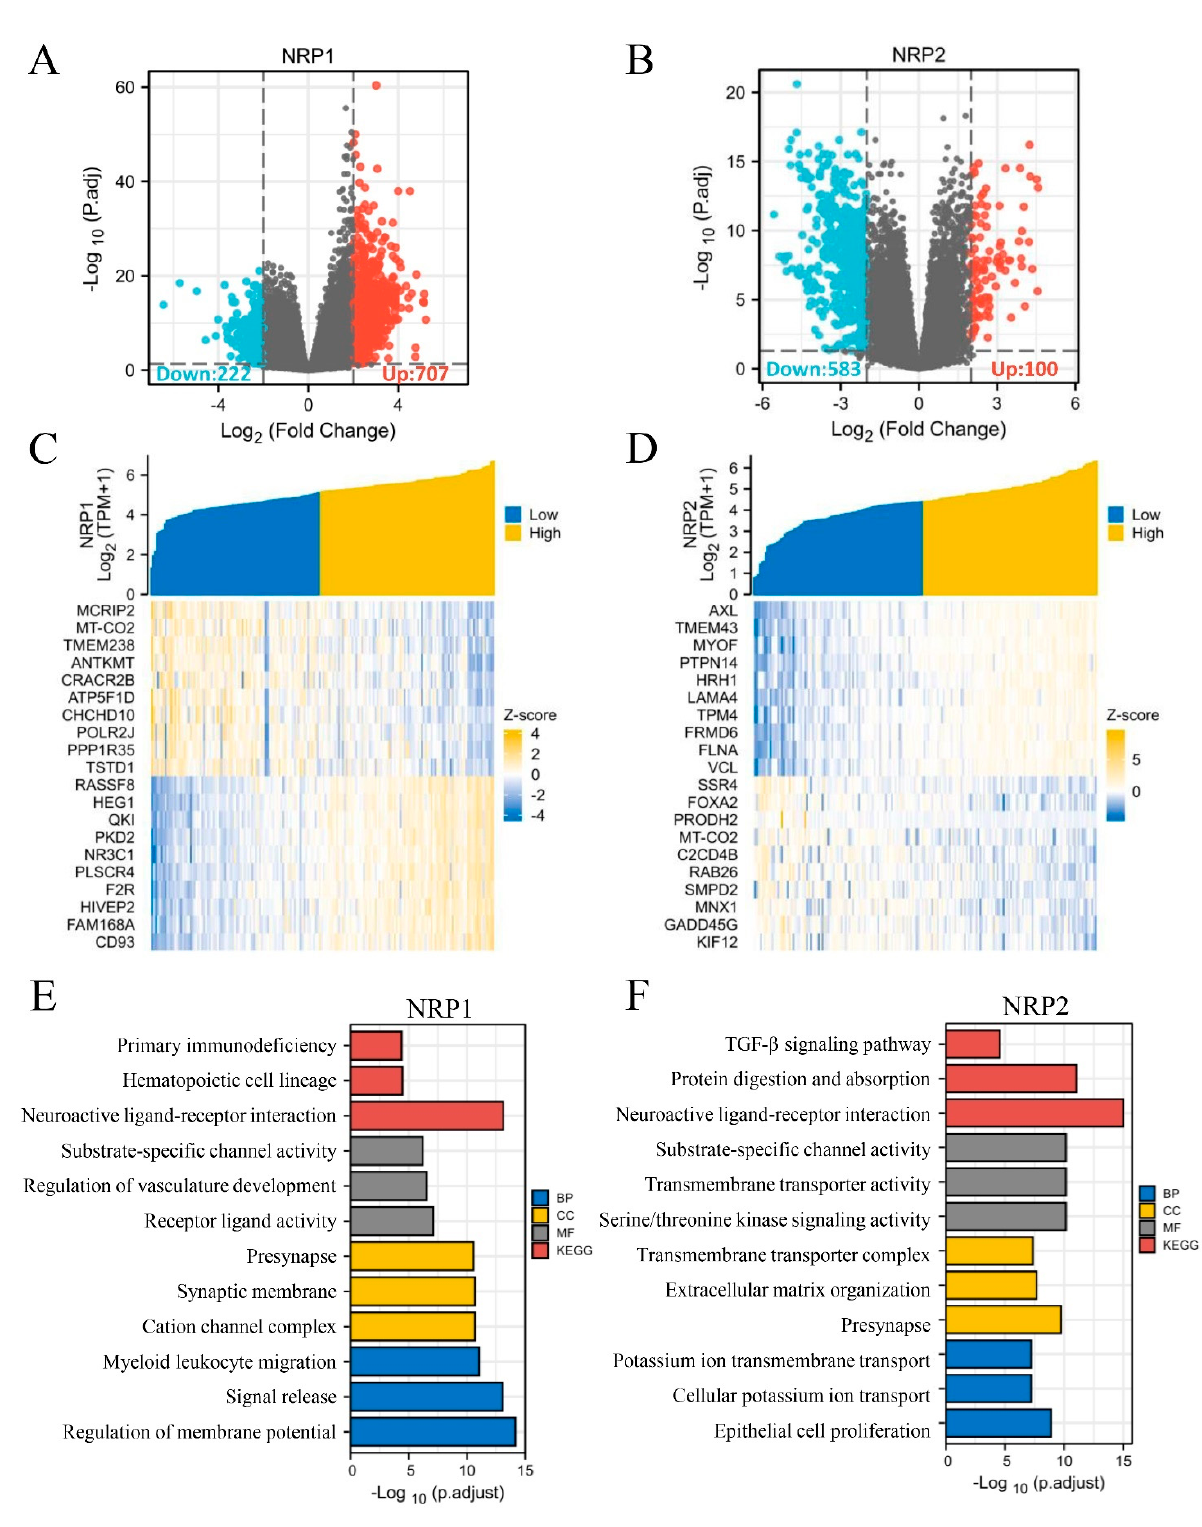
Figure 8. Differentially expressed genes of NRP and GO/KEGG analyses. ( A , B ) Volcano plot: red dots indicate significantly differentially up-regulated genes and blue dots indicate significantly differentially down-regulated genes. ( C , D ) Heatmap plot: the top 20 differentially expressed genes of NRPs. ( E , F ) GO/KEGG enrichment analysis. GO analysis contains biological pathways (BP), cellular components (CC) and molecular functions (MF).